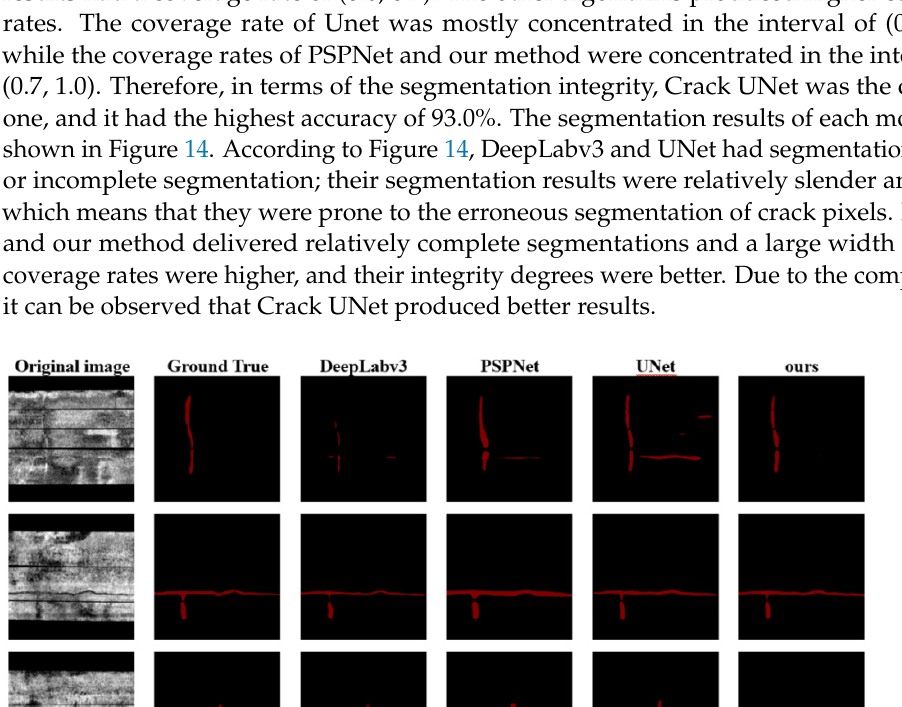
Table 4. The segmentation accuracy of each model under different false positive proportion thresholds using the non-crack test